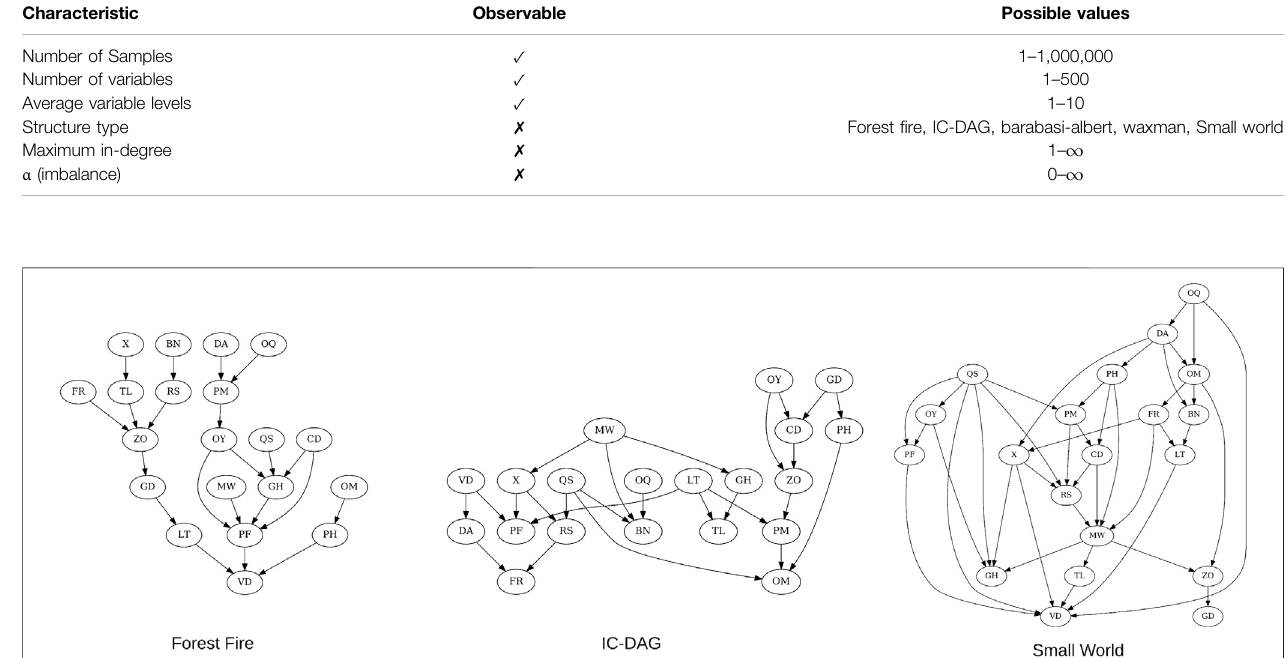
Frontiers in Arti fi cial Intelligence |